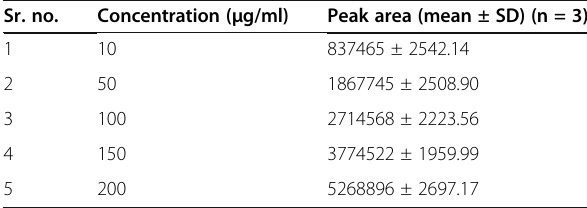
Table 4 Linearity of ceftriaxone sodium Sr. no.